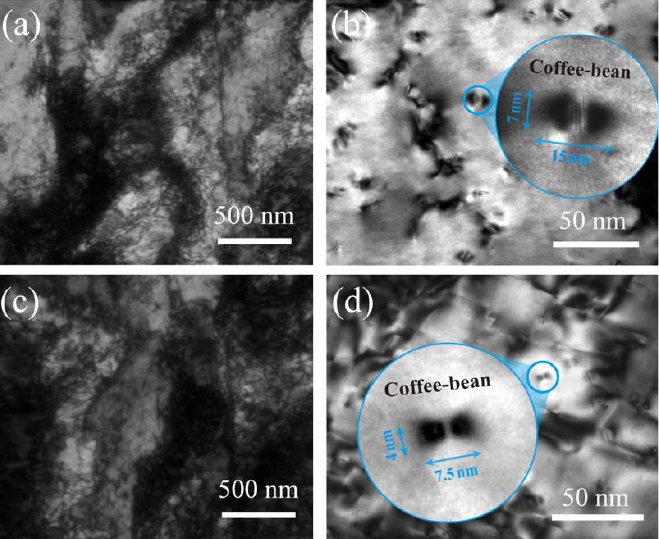
Figure 4. Bright-field images of ( a , b ) Cu-Cr and ( c , d ) Cu-Cr-Sn alloys after peak aging at 450 °C. Dislocation multiplication after cold deformation and Cr-rich phase precipitation during aging are the critical factors of microstructural and performance regulation with the Cu-Cr alloy. However, the evolution of dislocation and substructure and the coarsening of the precipitate at high temperature lead to the rapid decreases in the strength of the Cu-Cr alloy. Figure 5 shows the BF images of the Cu-Cr and Cu-Cr-Sn alloys during annealing at their respective softening temperatures. The dislocation density in the Cu-Cr alloy is gradually annihilated after annealing at 500 °C for 60 min, as shown in Figure 5a, and rearrangement formed dislocation cell organization during the movement. When the Cu-Cr-Sn alloy was held at 600 ◦ C for 60 min, annealing twins were observed between the dislocation structures as in Figure 5b. In addition, Figure 5c,d show the second phase particles in the alloy, and the morphology and size of the precipitated Cr phase evolved during higher temperature. The precipitated phase in the Cu-Cr alloy is mainly composed of moir é fringe and sphere-like morphologies, with an average size of ~14 nm. After annealing at 600 ◦ C, the precipitated Cr phases with moir é fringe morphology were also formed in the Cu-Cr-Sn alloy. The average size of precipitated particles was ~15 nm, and a huge number of dislocations were entangled around the precipitated particles. Figure 6 shows the BF images of the Cu-Cr and Cu-Cr-Sn alloys after annealing at 700 ◦ C for 60 min. It can be observed in Figure 6a that the undistorted recrystallized grains